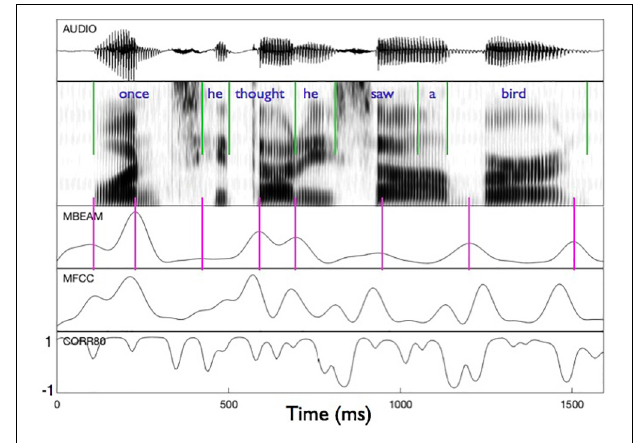
FIGURE 2 | Sample of modulation functions and their correlation function for the first clause of the test sentence, for one of the speakers. Panels represent (from top to bottom ): audio waveform, sound spectrogram, MBEAM modulation function filtered at 12 Hz, MFCC function filtered at 12 Hz, and the correlation function from Correlation Map Analysis for the narrow window condition, η = 0.8. Green vertical lines represent acoustic segmentation into syllables. Purple vertical lines mark the peaks of the MBEAM